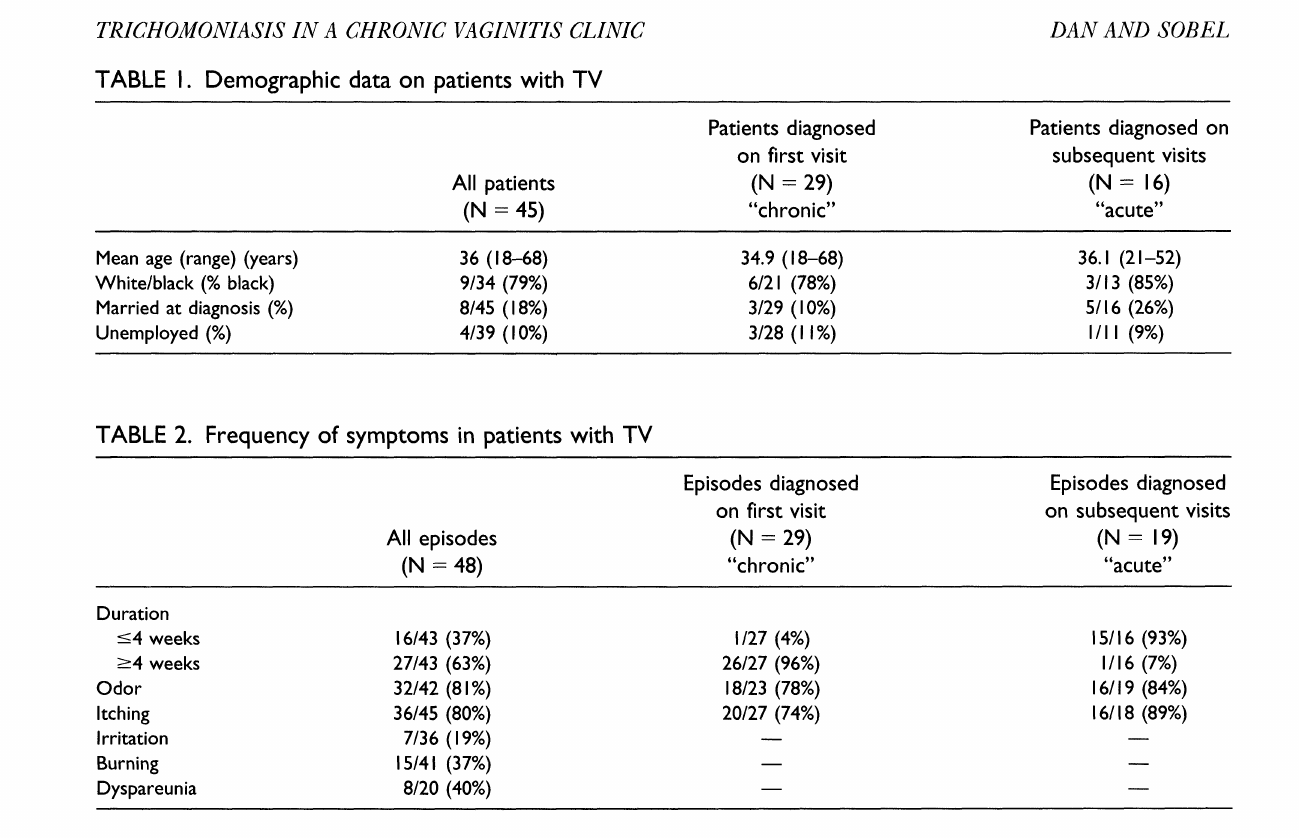
TABLE I. Demographic data on patients with TV